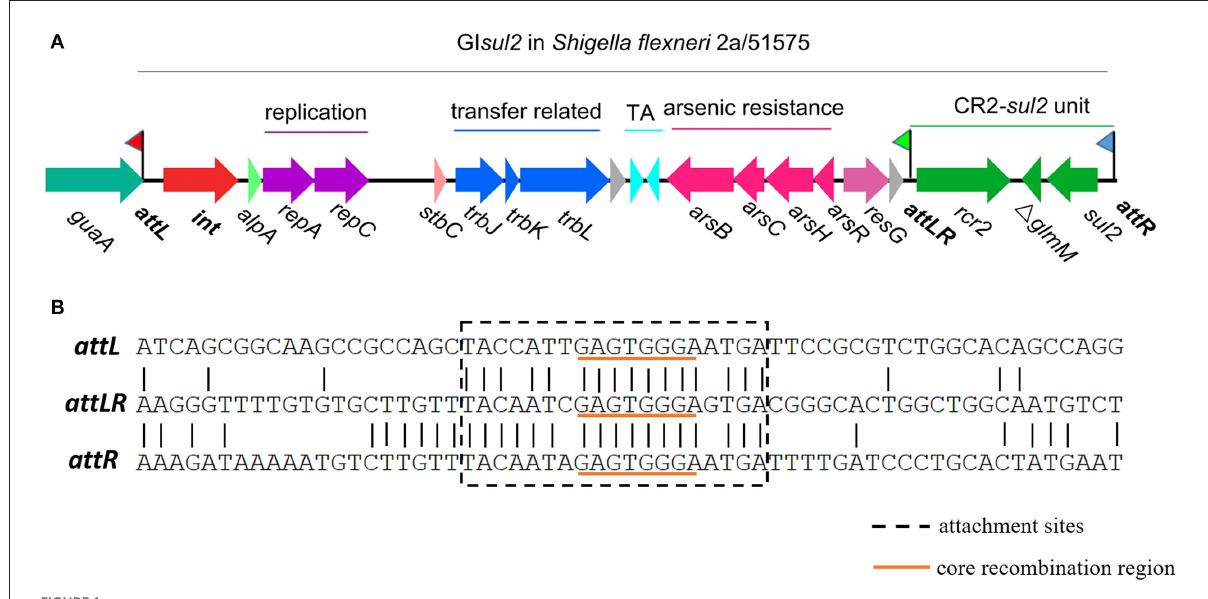
FIGURE1 Genetic organization of genomic island GI sul2 in S. flexneri 2a str. 2457T (accession AE014073) or S. flexneri 51575 (accession AZPD01000036, position 2108-17567). (A) Organization of the GI sul2 element. The thick central line represents the backbone of the GI sul2 with flags representing the three attachment sites ( attL/attLR/attR ). Horizontal arrows indicate the position, size, and orientation of ORFs with the names below. The guaA gene encoding a guanosine monophosphate synthetase (GMP) is shown in teal. The int gene encoding the integrase is represented in red. Bright green, light red, and pink ORFs denote alpA , stbC, and resG genes, respectively. Genes putatively involved in replication, transfer-related, toxin-antitoxin system, arsenic resistance, and the CR2 -sul2 unit are shown in purple, blue, cyan, pink and green, respectively. Gray ORFs encode hypothetical proteins. (B) Nucleotide alignment of att sites of GI sul2 . The dotted box represents the expected att sites recognized by the integrase. The orange underlined motif indicates the putative core recombination